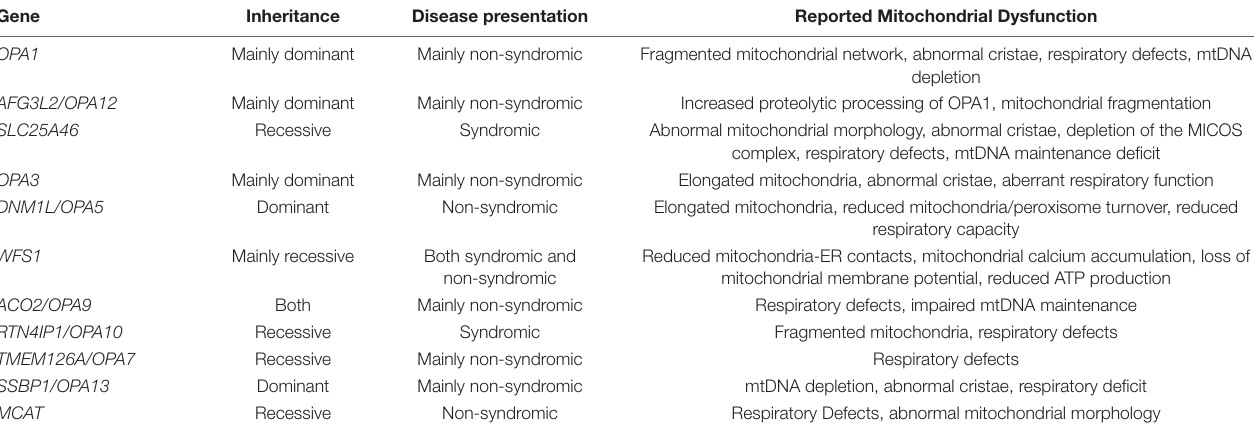
FIGURE 2 | Mitochondrial localization and function of autosomal OA genes. Schematic demonstrating the localization and function of proteins encoded by autosomal OA-associated genes. The localization of proteins encoded by autosomal OA-associated genes within and in association with the mitochondria emphasizes the relevance of these organelles to autosomal OA. WFS1 is localized to the ER, but is enriched at MAMs. DNM1L is recruited from the cytoplasm to the OMM to facilitate mitochondrial fission. There is conflicting evidence as to whether OPA3 is localized to the IMM or OMM. TABLE 1 | Summary of autosomal OA-associated genes and their